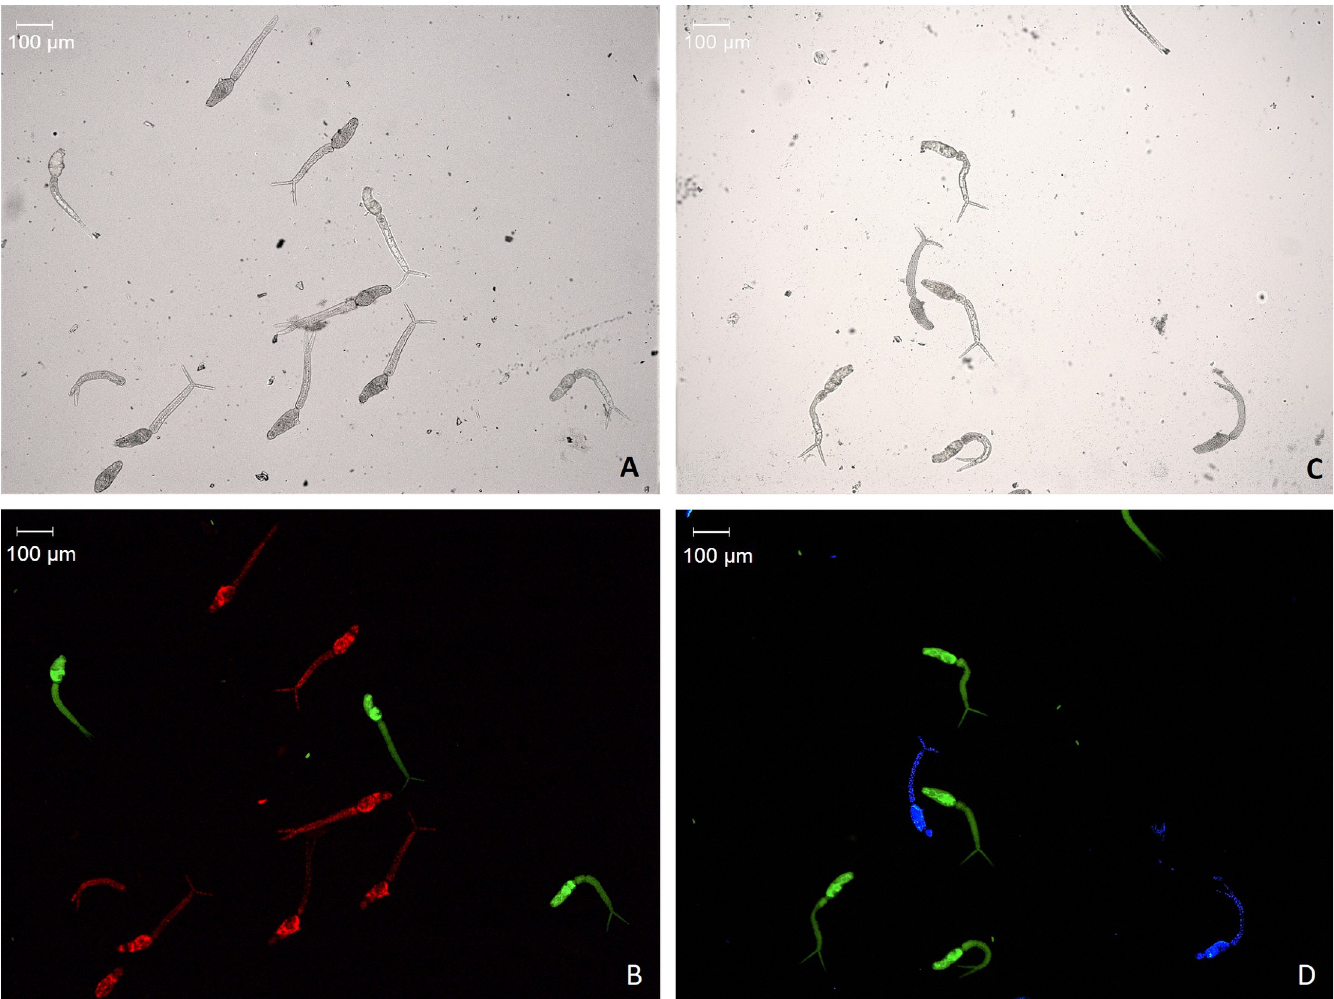
Fig 3. Cercariae double stained with FDA-PI (B) and FDA-H (D). Live, whole cercariae fluoresce green, whereas dead cercariae (often with their tail separated) fluoresce blue (Hoechst) or red (PI). Respective bright-field images of cercariae (A and C) shown for